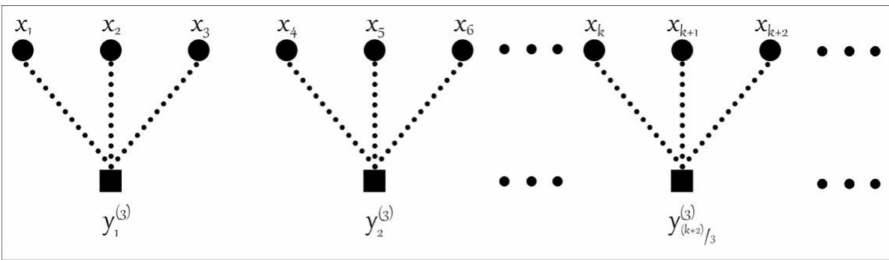
Figure 1. The traditional coarse-grained process with the scale factor s =